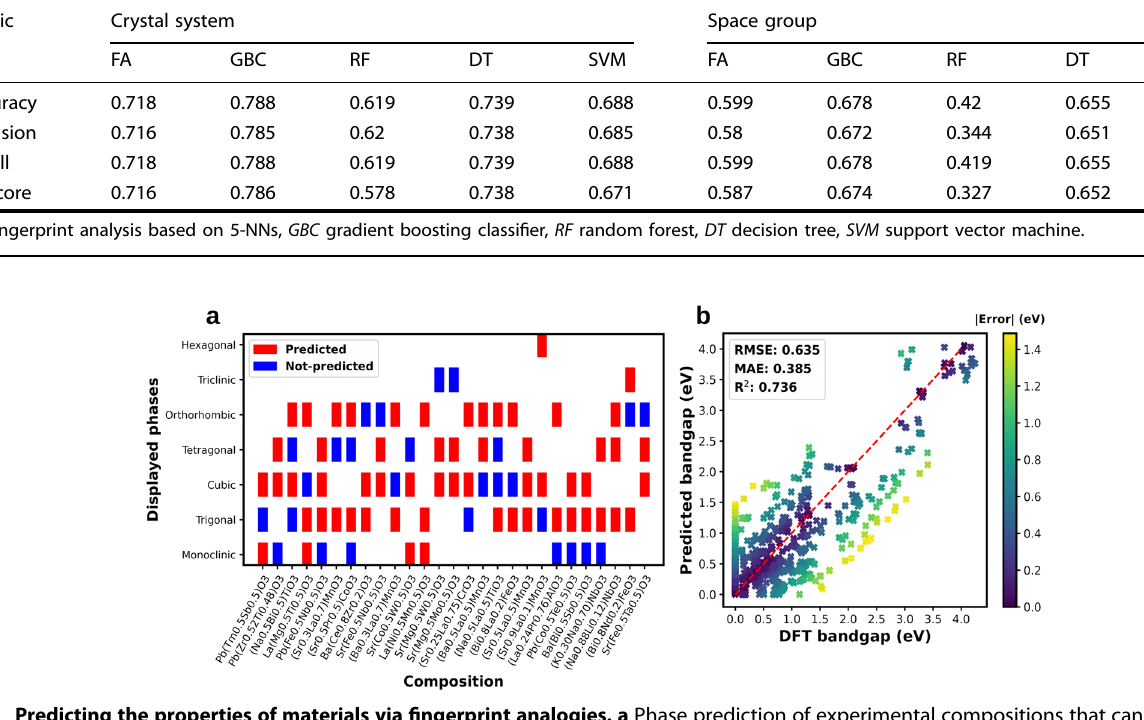
Fig. 5 Predicting the properties of materials via fi ngerprint analogies. a Phase prediction of experimental compositions that can crystallize in three or more phases. We focus only on the crystal system (i.e., the phase transitions occurring within a single crystal system are ignored). The phase is considered to be predicted if at least one of the 5-NNs belong to the crystal system of original composition. b Bandgap prediction results for a DFT database of quaternary perovskites 5 . It should be noted that generalized gradient approximation is used for the calculations in ref. 5 that tends to underestimate the bandgap.